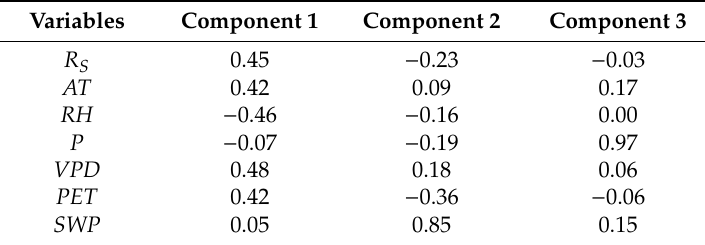
Table 3. Table of component weights